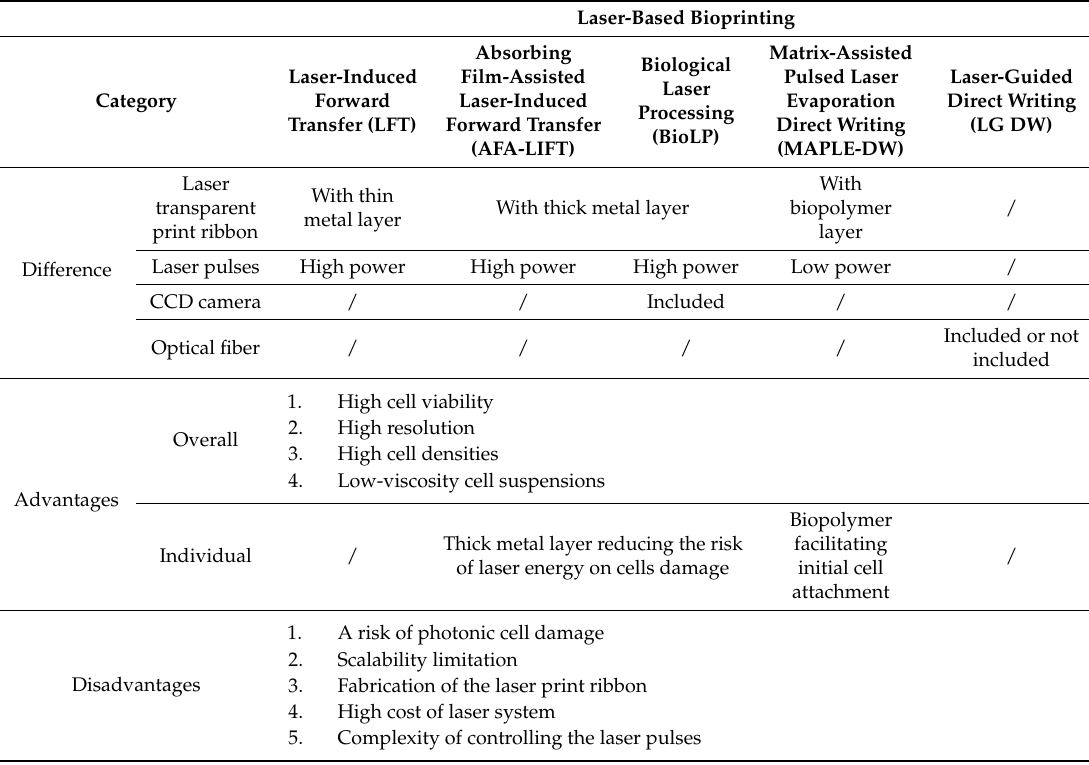
Table 1. The comparison among different laser-based bioprinting techniques.